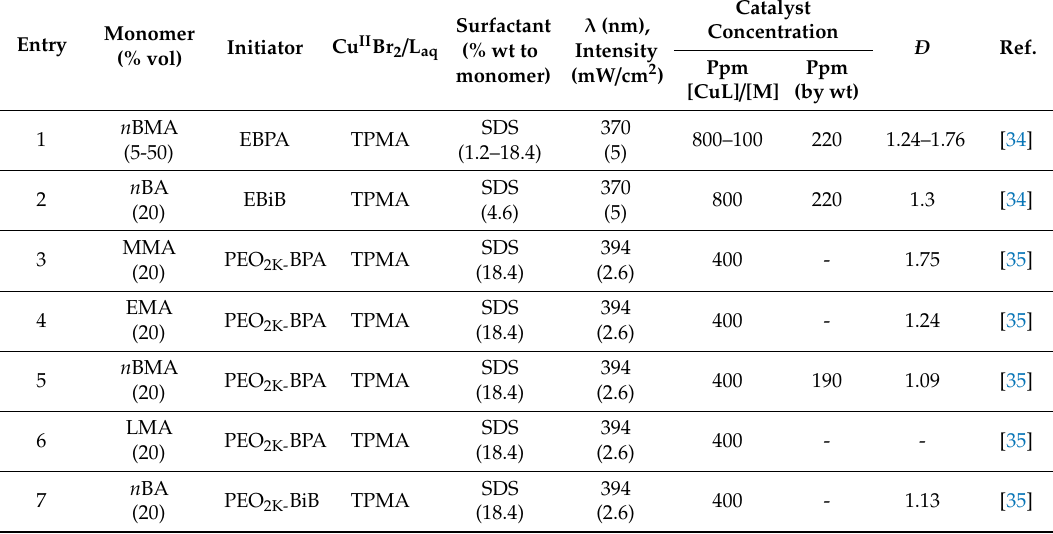
Table 3. Photo-ATRP in miniemulsion with different catalysts and monomers a .